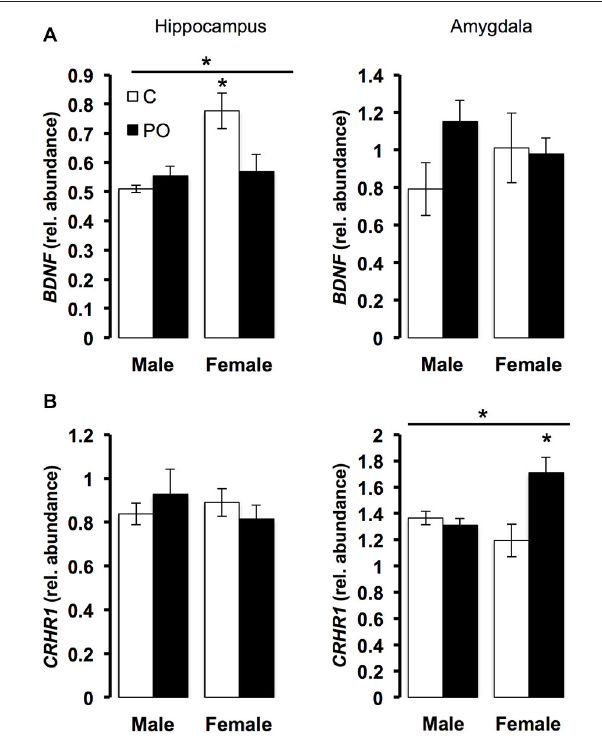
FIGURE 5 | Prenatal exposure to predator odor leads to differences in transcript abundance in the hippocampus and amygdala of the adult offspring . C, control; PO, offspring of predator odor exposed dams. Respectively, hippocampal and amygdala BDNF (A) and CRHR1 (B) transcript relative abundance corrected using YWHAZ transcript level. Data are average ± SEM. Bars, * P ≤ 0.05, main effect of maternal predator odor exposure; * P ≤ 0.05, post hoc comparison within sex.